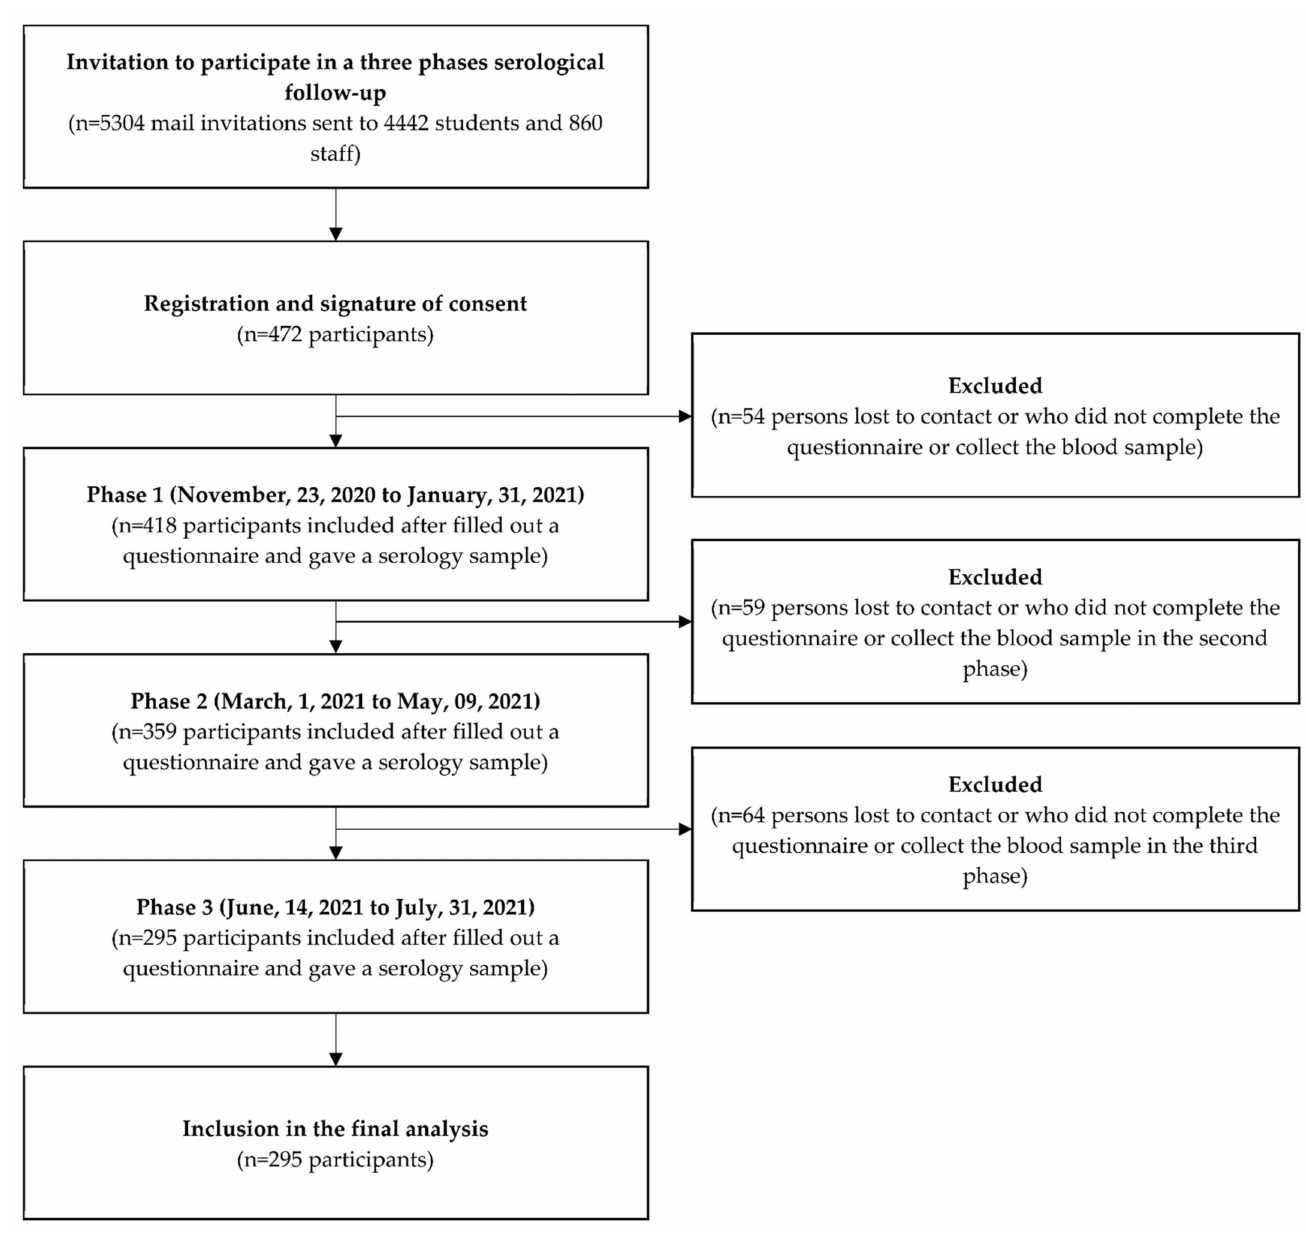
Figure 2. Flowchart of the study